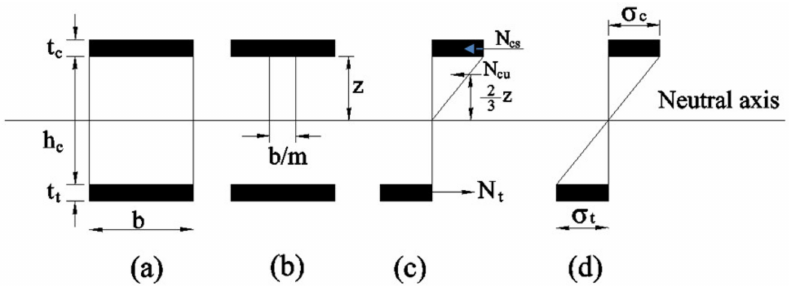
Figure 5. Sectional details for flexural resistance of SCS beam. ( a ) Section of (SCS) beam; ( b ) Equivalent section; ( c ) Compressive and tensile forces distribution ( d ) Idealized stress